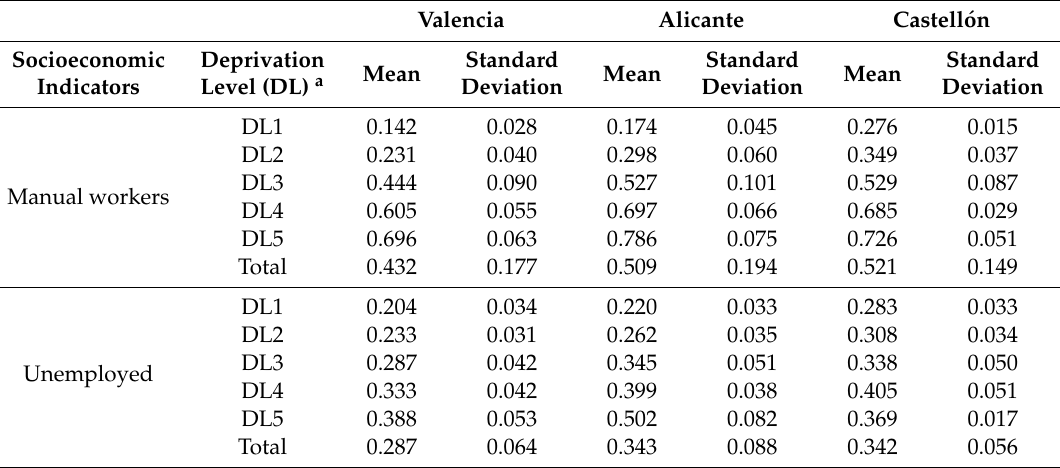
Table A1. Average values of the socioeconomic indicators that make up the deprivation index (2011 census) by study of the three cities and classification based on percentiles of the deprivation